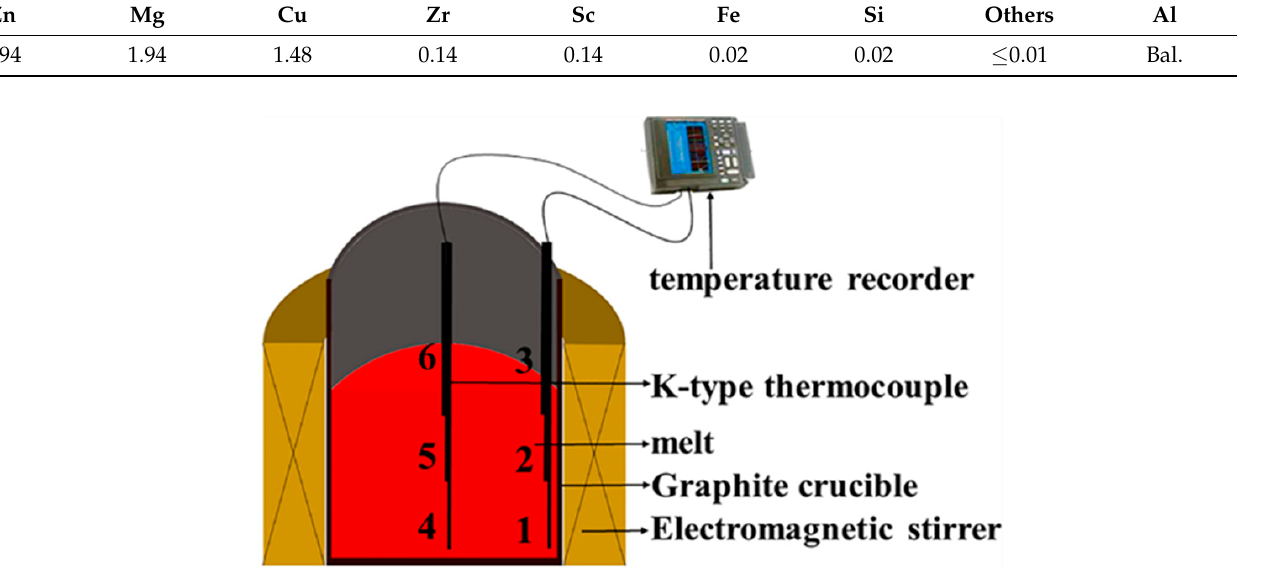
Figure 1. Schematic diagram of ESMT.